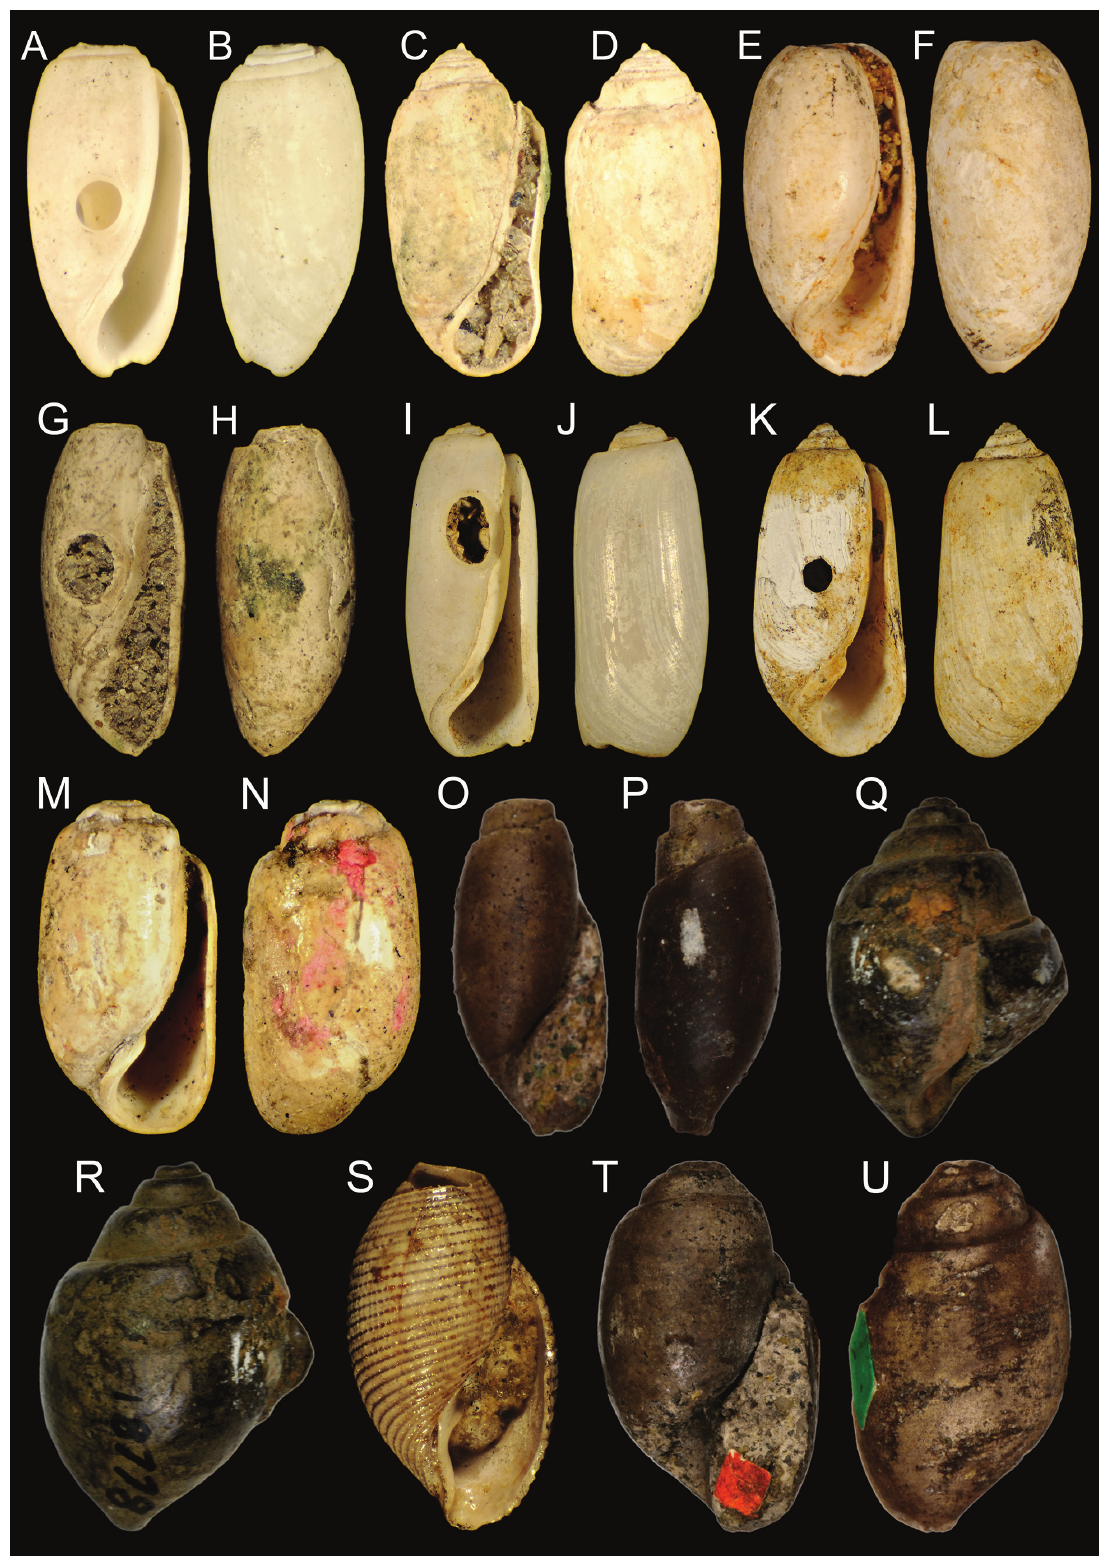
Figure 1. Types. A–B. Holotype of Acteocina cederstromi , H 4.0 mm, ANSP IP16771. C–D. Holotype of Acteocina chowanensis , H 3.8 mm, ANSP IP16754. E–F. Lectotype of Acteocina crassiplica , H 6.0 mm, ANSP IP13412. G–H. Paratype of Acteocina kirk- woodiana , H 5.0 mm, ANSP IP15935. I–J. Holotype of Acteocina puruha , H 7.6 mm, ANSP IP13684. K–L. Holotype of Acteocina subbullata , H 9.9 mm, ANSP IP3193. M–N. Syntype of Acteocina weatherlli , H 4.6 mm, ANSP IP14431. O–P. Syntype of Acteon biplicatus , H 17.2 mm, ANSP IP19466; also, syntype of A. gabbana . Q–R. Syntype of Acteon cretacea , H 19.1 mm, ANSP IP18778. S. Holotype of Acteon elegans , H 6.0 mm, ANSP IP6011. T–U. Syntype of Acteon forbesiana , H 9.2 mm, ANSP